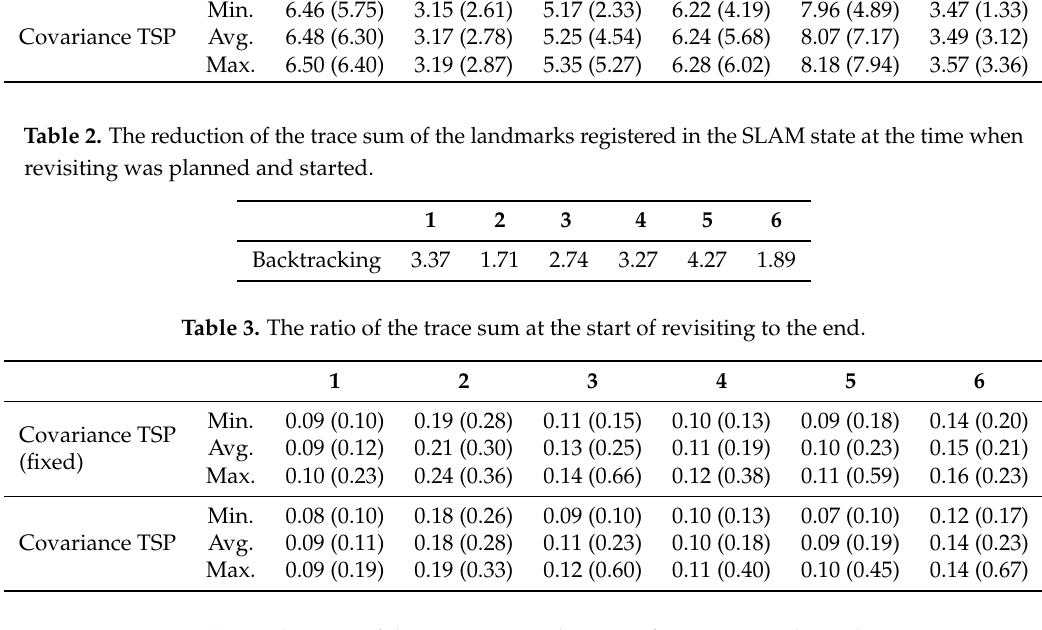
Table 4. The ratio of the trace sum at the start of revisiting to the